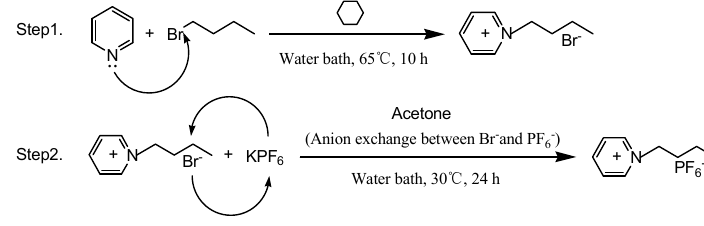
Table 2. The recovery rate of the determination of Fe 2+ in Tieguanyin tea. Sample